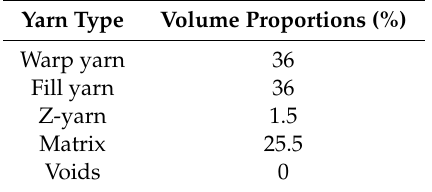
Figure 6. Flow chart showing steps of volume averaging method. Table 5. Volume proportion of impregnated